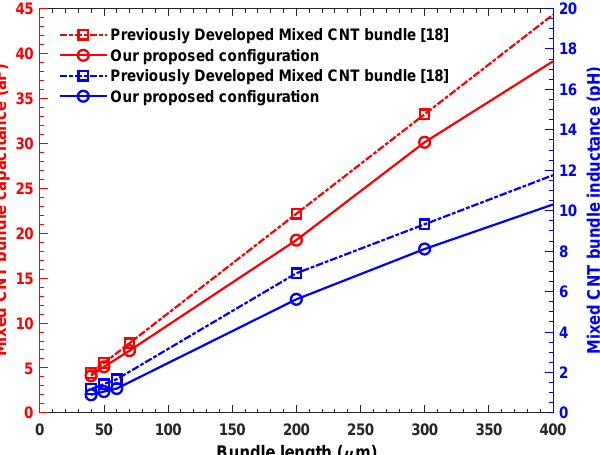
Figure 6. Findings of overall bundle inductance ( L ) and capacitance ( C ) for different interconnect lengths to observe the comparative parameter illustration of the proposed configuration and the previous model by considering that 2 of the CNTs are metallic in the 3